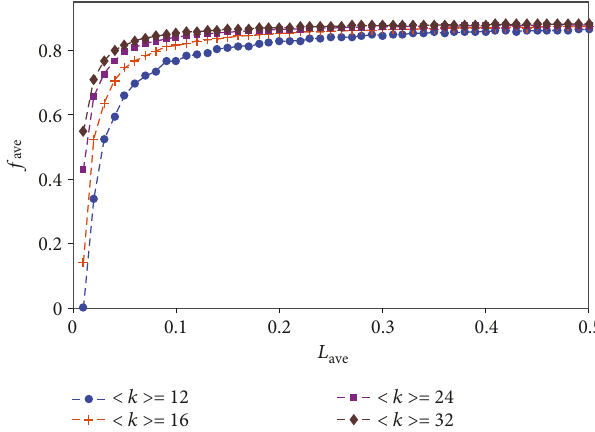
Figure 6: The evolution of the network varies with L di ff erent value of < k > .